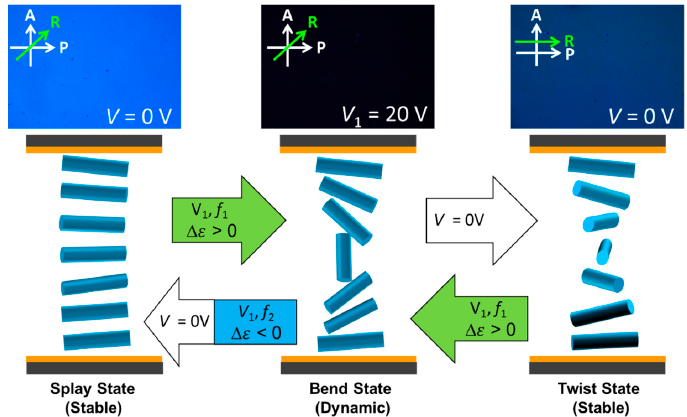
Figure 1. Dual-mode switching in the 1D PC/CD-DFLC hybrid cell. Here, f 1 and f 2 denote the frequencies for inducing positive and negative dielectric anisotropy in DFLC, respectively. V 1 is the amplitude of an applied voltage pulse for realizing the state transition from the sS or sT to high-tilted bB state.